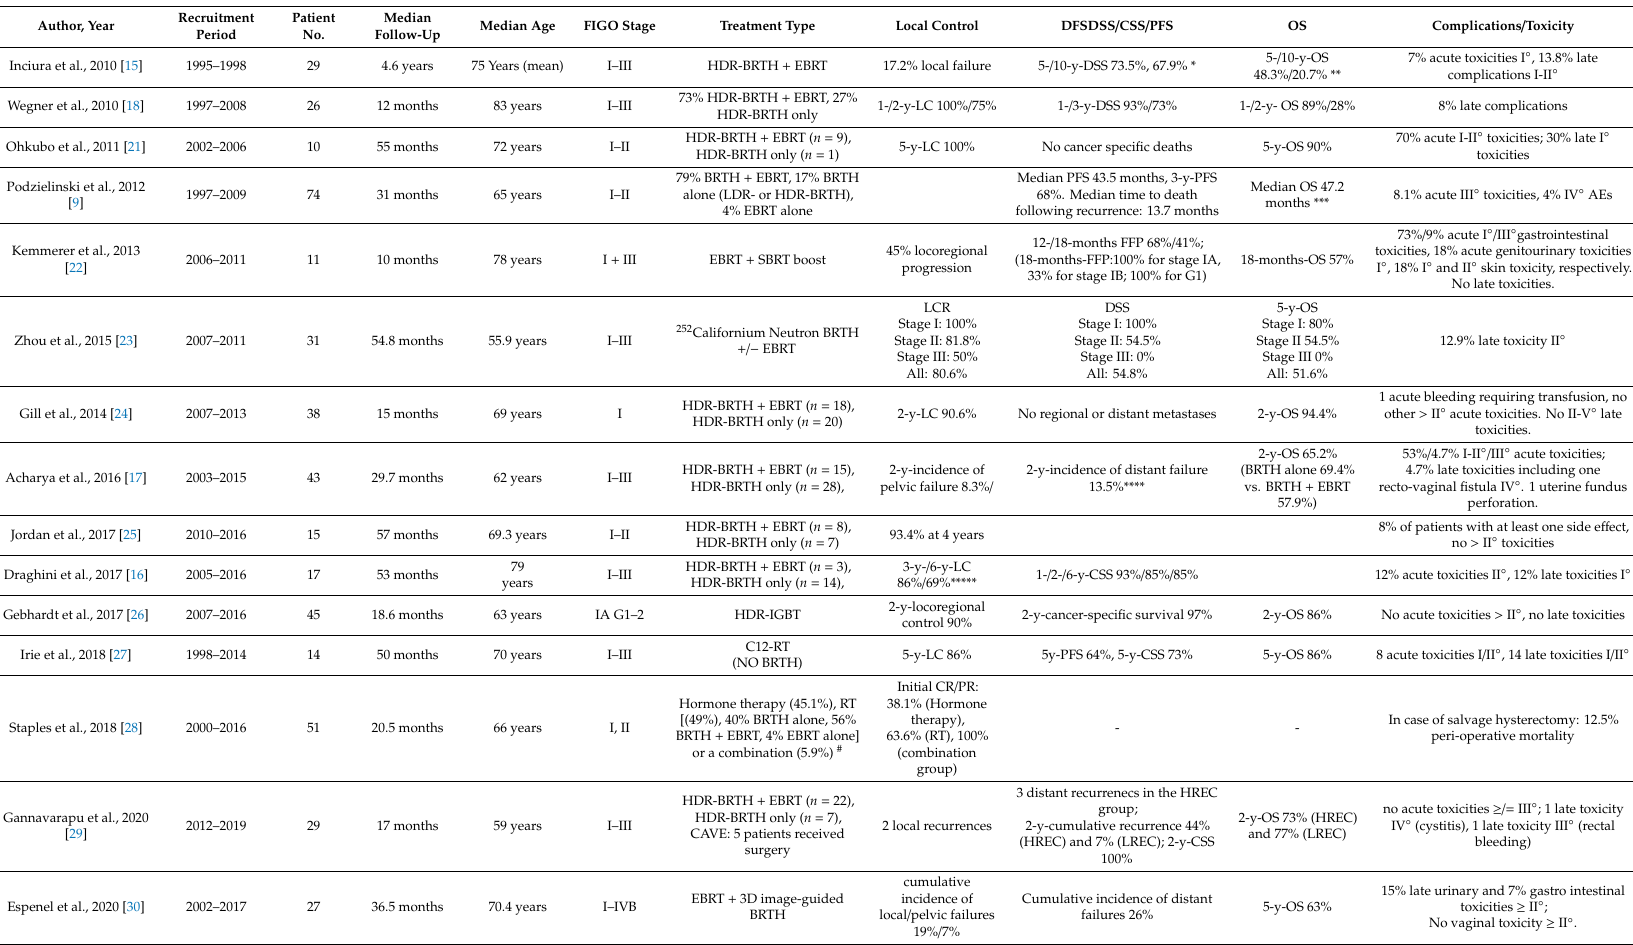
Table 1. Review of published data from 2010 to